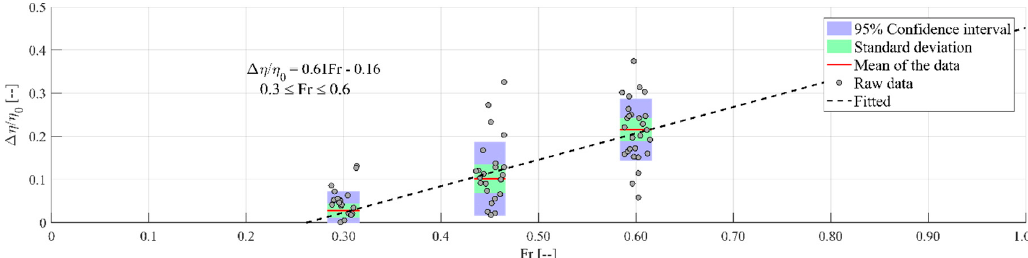
Figure 13. Backwater rise as a function of the Froude number. For each hydrodynamic boundary condition, all equilibrium backwater rise is displayed as a grey dot; the mean of hydrodynamic boundary condition is displayed as a solid line.